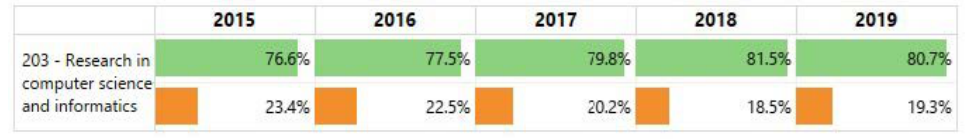
Figure 2. Data from the 2015-2019 Annual List of Social Information (RAIS) on the performance of men and women in scientific